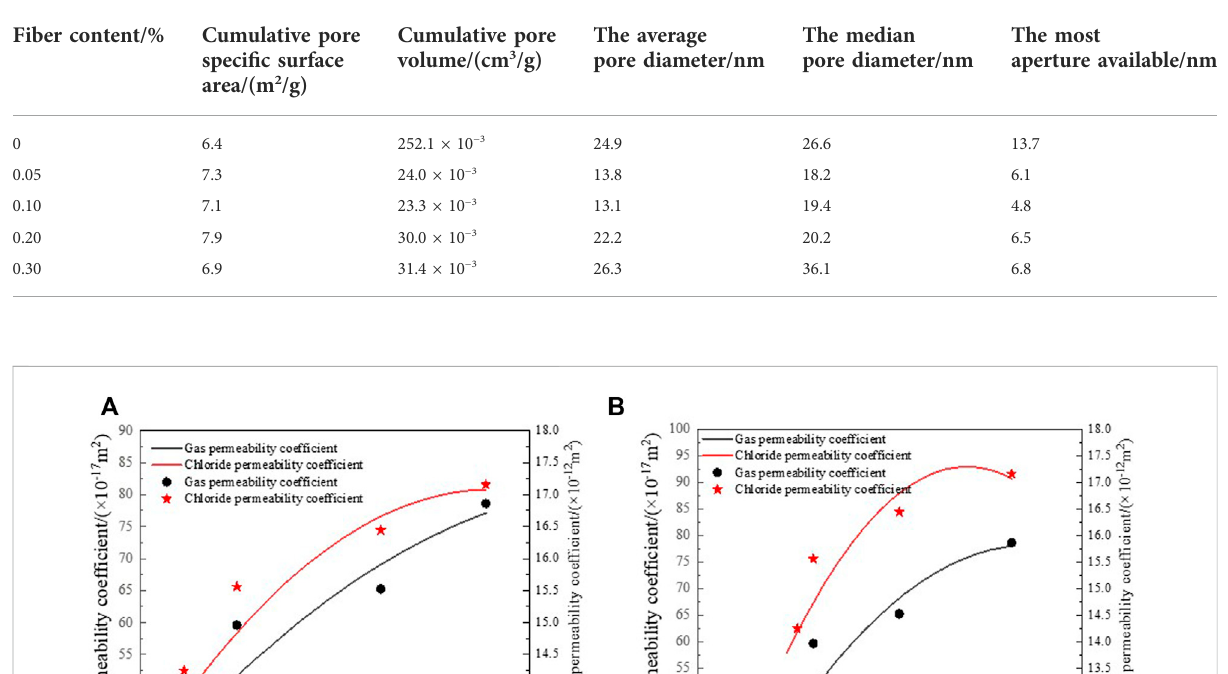
TABLE 2 Pore size distribution of BFRC with different fi ber content (Yin, 2015).